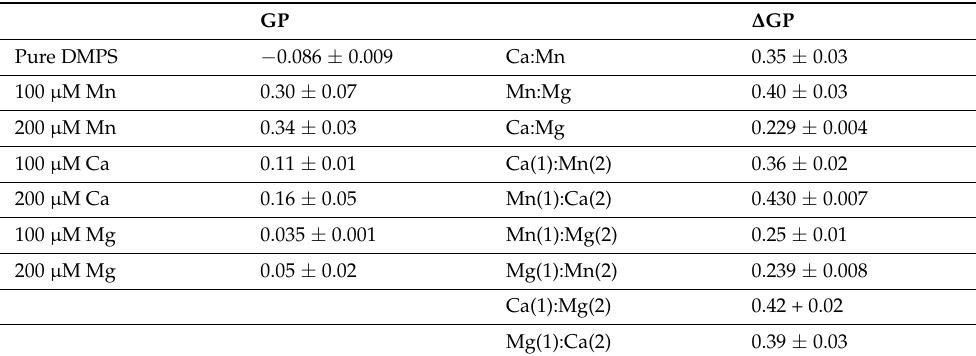
Table 7. Tabulated GP and ∆ GP values of DMPS with varying concentration of Mn, Ca, Mg and metal mixtures.